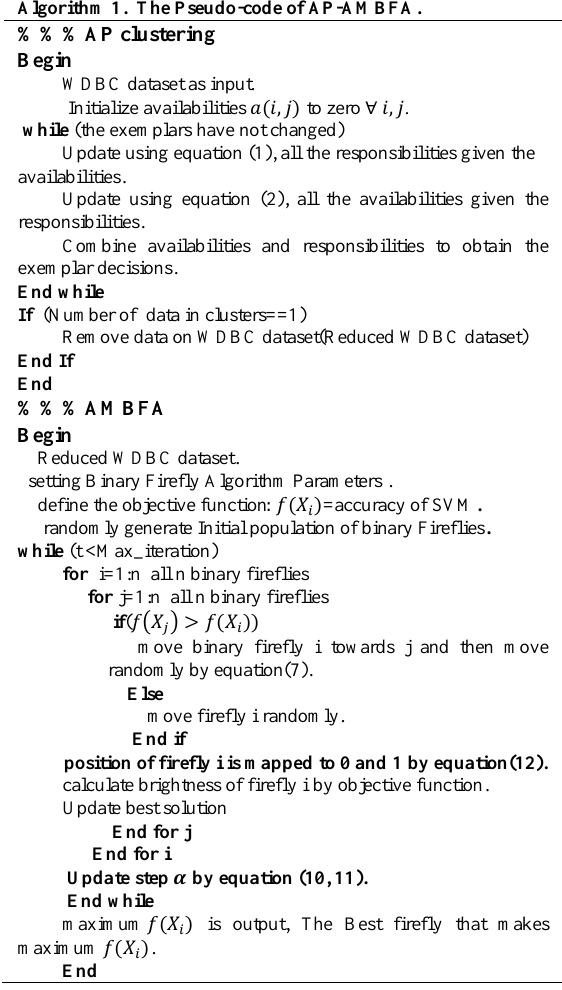
Algorithm 1. The Pseudo-code of